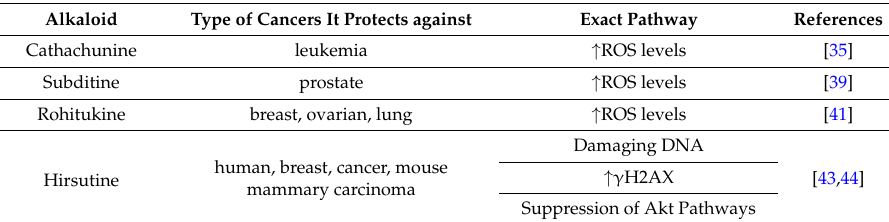
Table 2. Emerging DNA damaging plant-derived alkaloids.